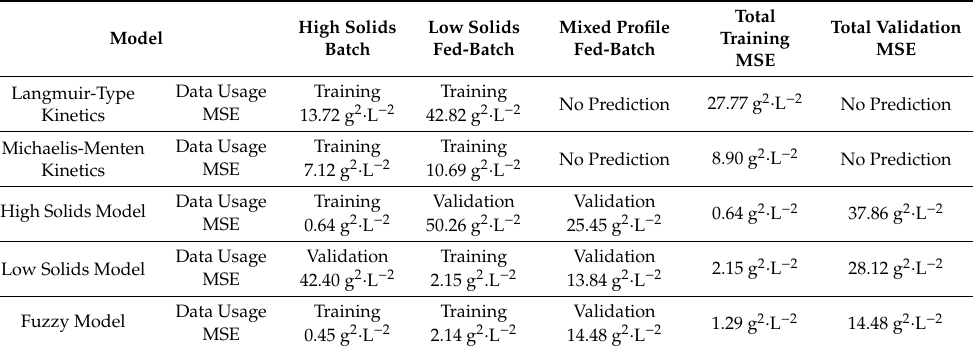
Figure 4. Fuzzy model, high solids model and low solids model fitting data prediction—( a ) Models prediction for Data Set 1; ( b ) Models prediction for Data Set 2; error bars in data points are the standard errors between experiment’s duplicates for the compound concentration; vertical dotted lines are the solids feeding times. Table 3. Fitting error summary for proposed